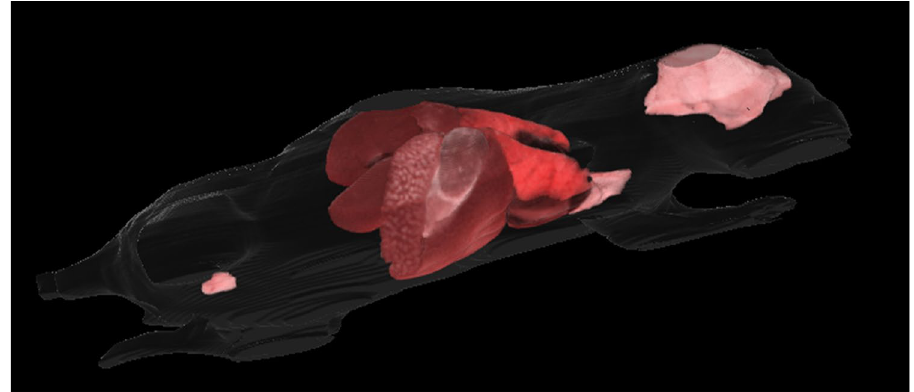
Figure 3. 3D true color volume rendering of segmented mouse organs from 2D-slices results. The organs are volume rendered and the mouse body label is surface rendered. The organs have various textures and colors.